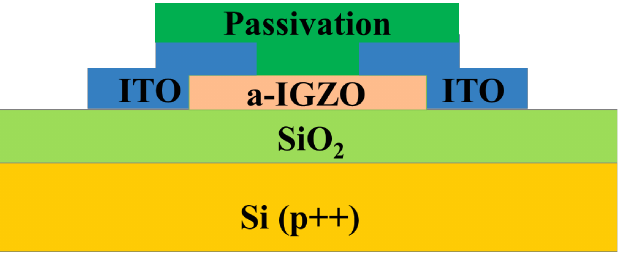
Figure 1. Schematic cross-section of the inverted staggered amorphous InGaZnO (a-IGZO) thin-film transistors (TFTs).